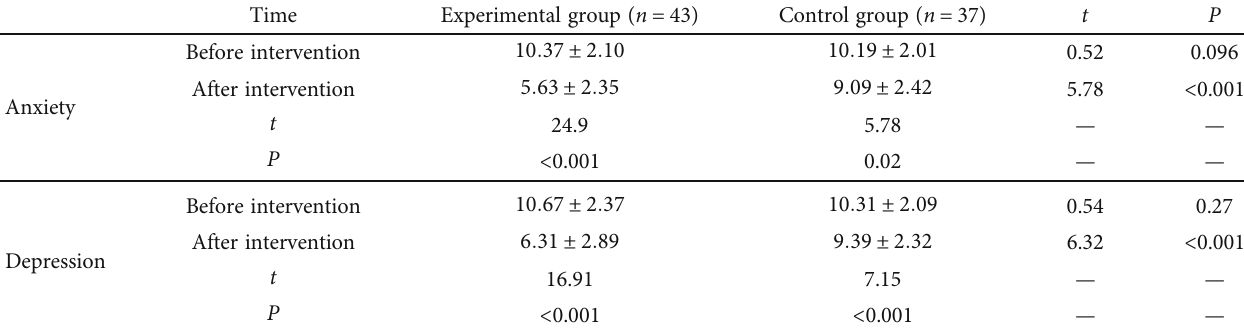
Table 2: Comparison of Hospital Anxiety and Depression Scale (HADs) between the two groups after intervention (points, (cid:1) x ± s